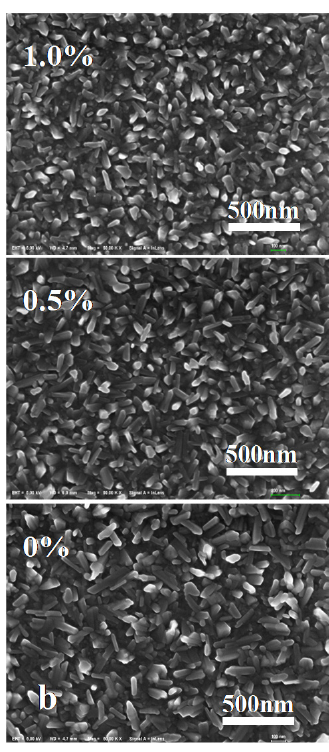
Figure 7. XRD patterns ( a ) and SEM images ( b ) of the W-doped VO 2 thin films prepared by profes- sional annealing of 45 nm W:V films at 450 Pa, 400 °C for 1 h.